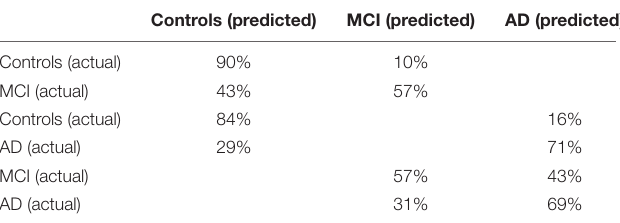
TABLE 7 | Confusion matrices of the SVM (linear) for the controls and MCI patients classification and the controls and AD patients classification, and the ANN (6 neurons) for the MCI patients and AD patients classification.